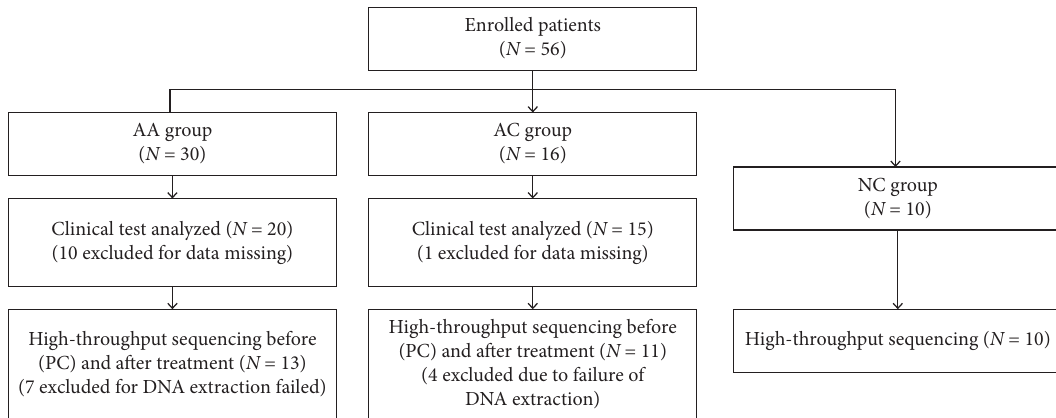
Figure 1: Flow diagram of the trial; forty-six patients with RAS were enrolled into our trial, and then 11 patients (10 in AA and 1 in AC) were excluded due to data missing from the clinical test analysis. Moreover, 11 patients (7 in AA and 4 in AC) were excluded from high- throughput sequencing analysis as the DNA extraction failed. Additionally, 10 healthy individuals were selected for high-throughput sequencing as a negative control group. Table 1: Patients’ baseline information and characteristics.